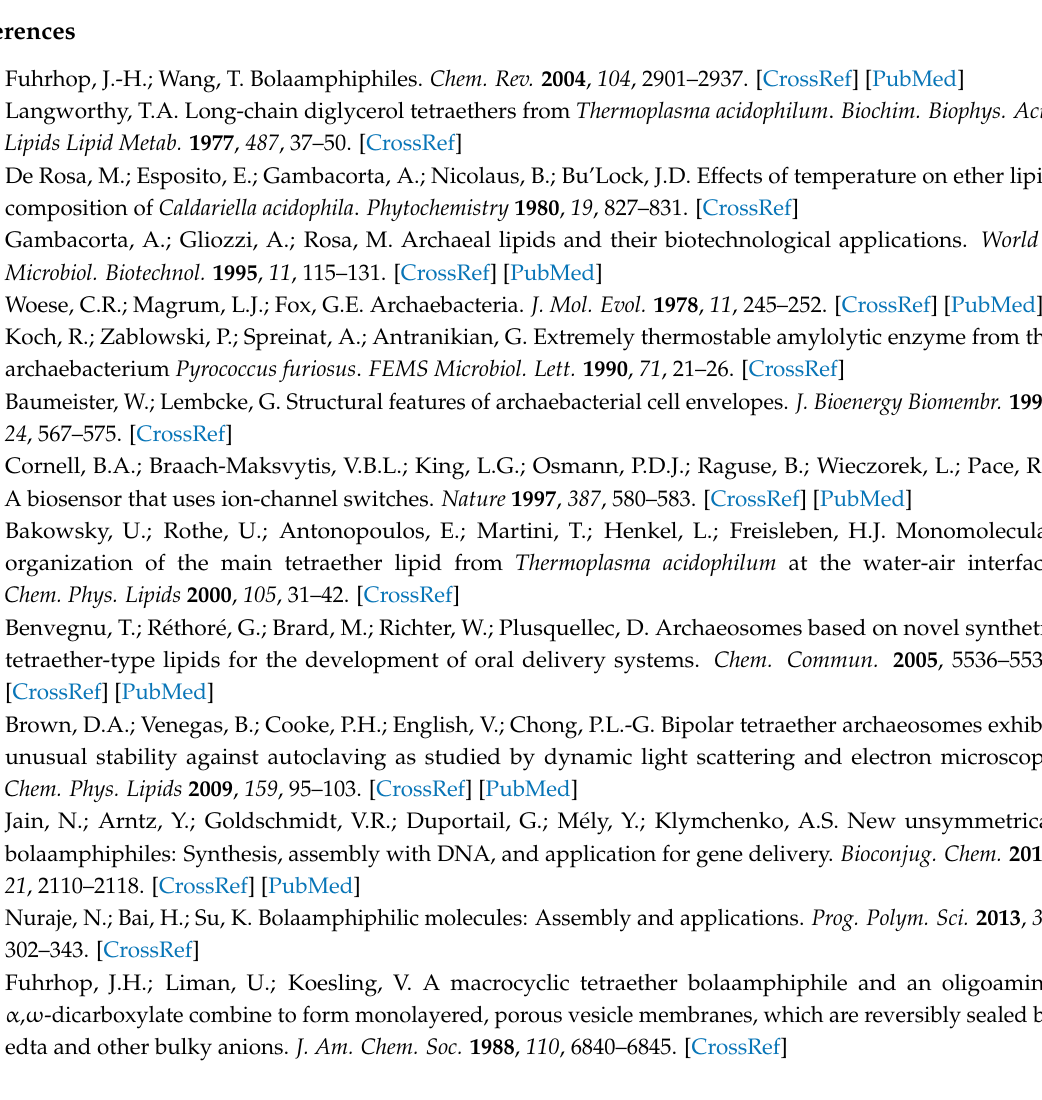
Figure S1. MS data (negative mode) of Me 2 PE-Gly(2C16)C32-OBn . Figure S2. MS data (positive mode) of Me 2 PE-Gly(2C16)C32-OBn . Figure S3. 1 H-NMR data of Me 2 PE-Gly(2C16)C32-OBn . Figure S4. 13